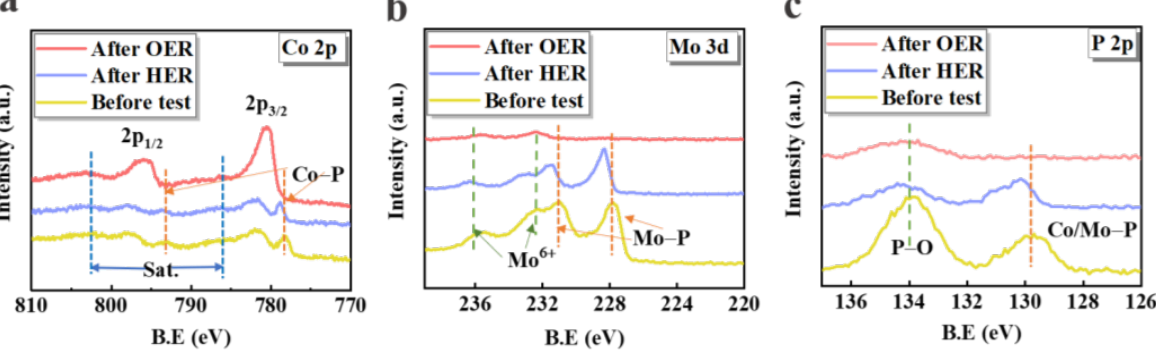
Figure 6. High-resolution XPS spectra of CoMoP NFs-virgin, post HER, and post OER; ( a ) Co 2p, ( b ) Mo 3d, and ( c ) P 2p.